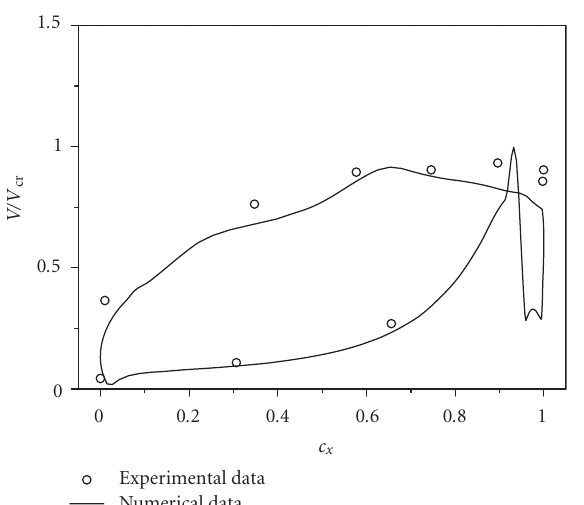
Figure 4: Critical velocity ratio at the midspan of the vane.